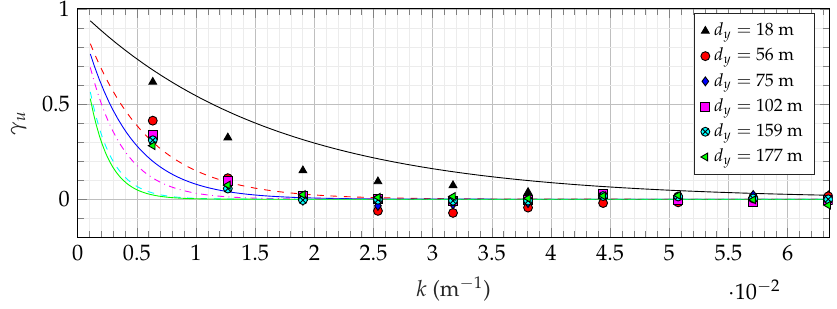
Figure 12. Measured (scatter plot) lateral wind coherence of the along-wind component recorded using the data from LW2 and LE from 18 May 2016 to 21 June 2016 (E-W configuration) fitted with Equation (15) (smooth